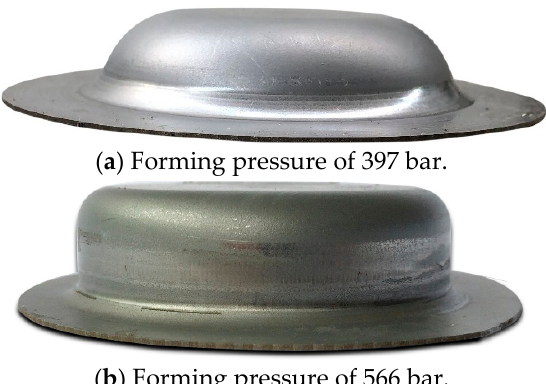
Figure 7. Products at different forming pressures.